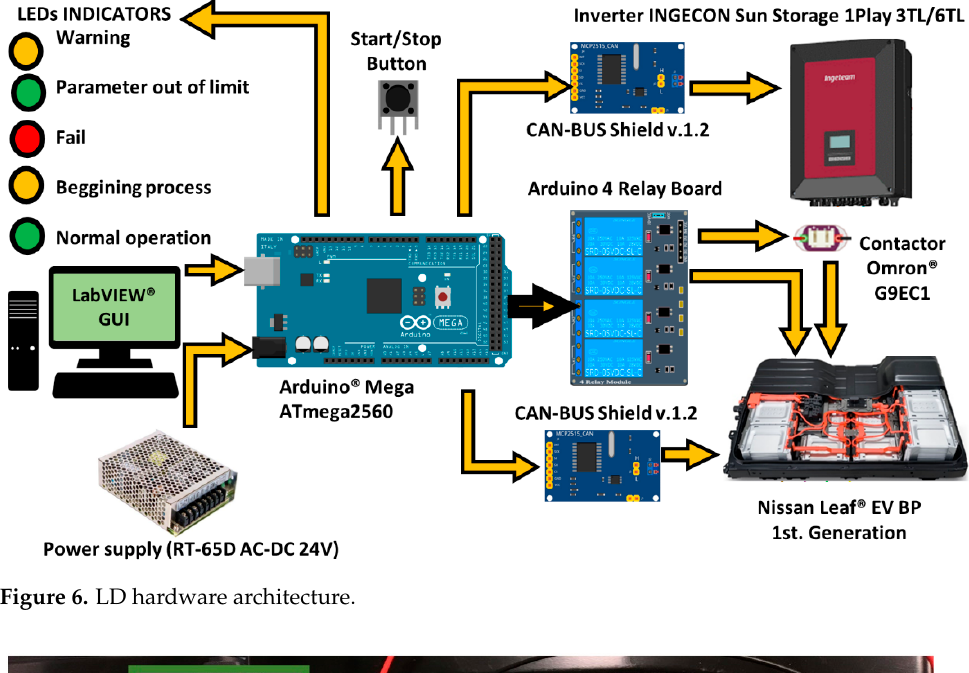
Figure 6. LD hardware architecture.